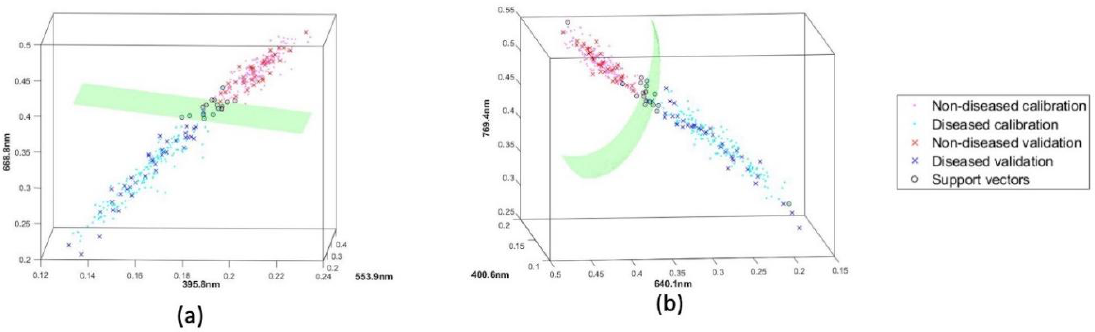
Figure 6. The decision boundaries are visualized in raw data for classification between sound and diseased rice samples by using ( a ) SVM and ( b ) RBF SVM classification methods with three features.